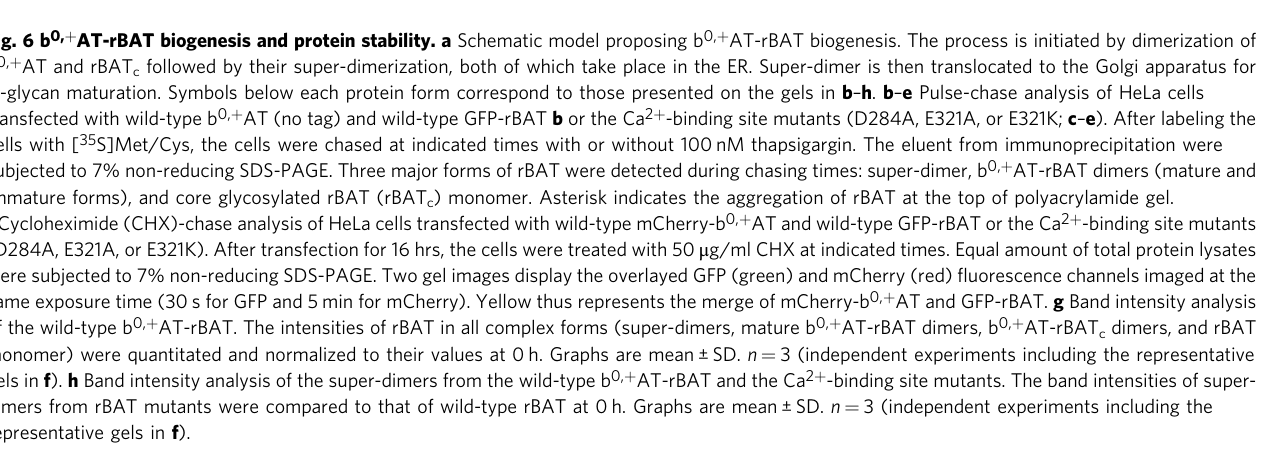
Fig. 6 b 0, + AT-rBAT biogenesis and protein stability. a Schematic model proposing b 0, + AT-rBAT biogenesis. The process is initiated by dimerization of b 0, + AT and rBAT c followed by their super-dimerization, both of which take place in the ER. Super-dimer is then translocated to the Golgi apparatus for N-glycan maturation. Symbols below each protein form correspond to those presented on the gels in b – h . b – e Pulse-chase analysis of HeLa cells transfected with wild-type b 0, + AT (no tag) and wild-type GFP-rBAT b or the Ca 2 + -binding site mutants (D284A, E321A, or E321K; c – e ). After labeling the cells with [ 35 S]Met/Cys, the cells were chased at indicated times with or without 100 nM thapsigargin. The eluent from immunoprecipitation were subjected to 7% non-reducing SDS-PAGE. Three major forms of rBAT were detected during chasing times: super-dimer, b 0, + AT-rBAT dimers (mature and immature forms), and core glycosylated rBAT (rBAT c ) monomer. Asterisk indicates the aggregation of rBAT at the top of polyacrylamide gel. f Cycloheximide (CHX)-chase analysis of HeLa cells transfected with wild-type mCherry-b 0, + AT and wild-type GFP-rBAT or the Ca 2 + -binding site mutants (D284A, E321A, or E321K). After transfection for 16 hrs, the cells were treated with 50 μ g/ml CHX at indicated times. Equal amount of total protein lysates were subjected to 7% non-reducing SDS-PAGE. Two gel images display the overlayed GFP (green) and mCherry (red) fl uorescence channels imaged at the same exposure time (30 s for GFP and 5 min for mCherry). Yellow thus represents the merge of mCherry-b 0, + AT and GFP-rBAT. g Band intensity analysis of the wild-type b 0, + AT-rBAT. The intensities of rBAT in all complex forms (super-dimers, mature b 0, + AT-rBAT dimers, b 0, + AT-rBAT c dimers, and rBAT monomer) were quantitated and normalized to their values at 0 h. Graphs are mean ± SD. n = 3 (independent experiments including the representative gels in f ). h Band intensity analysis of the super-dimers from the wild-type b 0, + AT-rBAT and the Ca 2 + -binding site mutants. The band intensities of super- dimers from rBAT mutants were compared to that of wild-type rBAT at 0 h. Graphs are mean ± SD. n = 3 (independent experiments including the representative gels in f